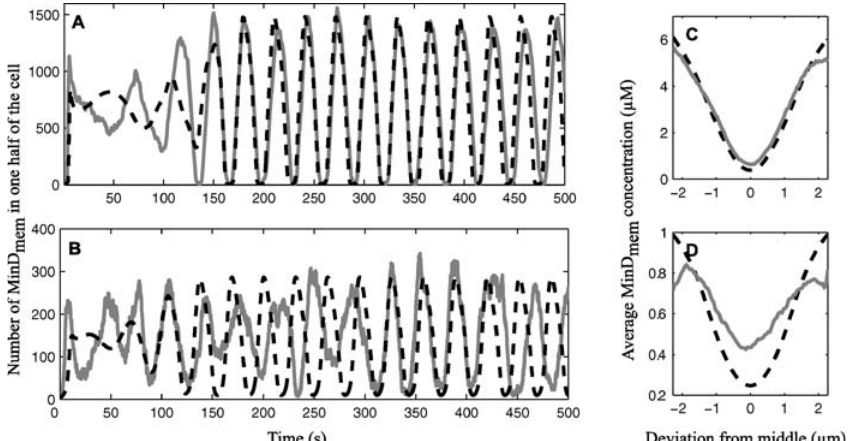
Figure 4. Comparison of Stochastic and Deterministic Simulations at Different Concentrations of MinD and MinE in a wt Cell The number of membrane-bound MinD molecules in one half of a cell for wt (A) and 25% of wt concentration (B). Time-averaged localization of MinD for stochastic and deterministic simulation for wt concentration (C) and for 25% of wt concentration (D). Stochastic simulations are show in solid gray, and deterministic simulations in dashed black. DOI: